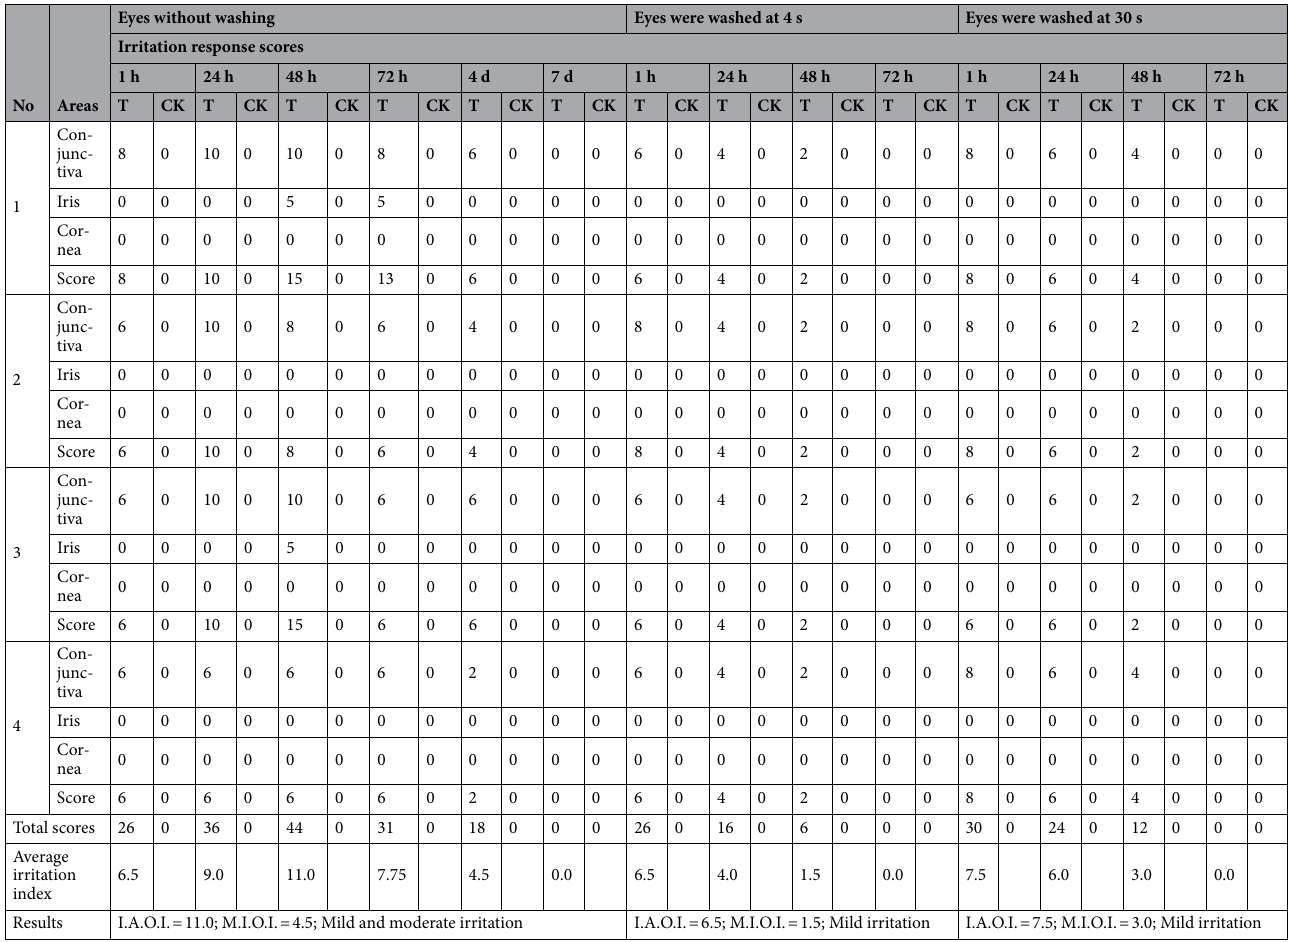
Table 4. Evaluation of acute eye irritation about the 10% EW of BE. Note: T was treatment in this table; I.A.O.I. = Acute index of eye irritation; M.I.O.I. = The mean index of eye irritation.